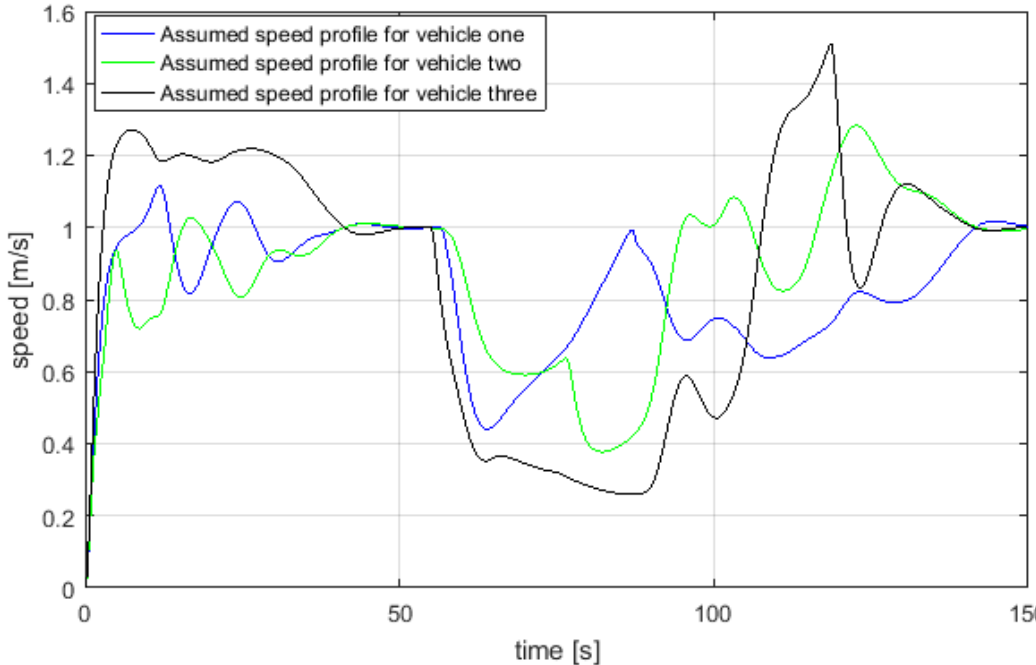
Figure 13. USV speed profiles assumed during swarm aggregation evolution for three USVs.